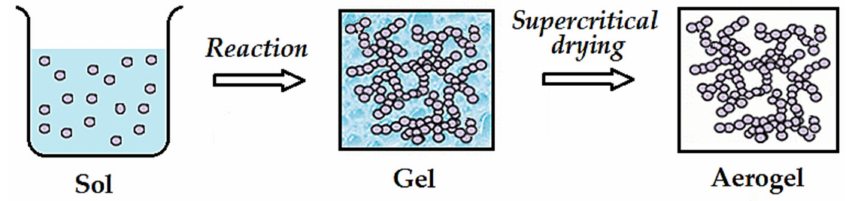
Figure 4. A sketch of sol–gel and supercritical drying